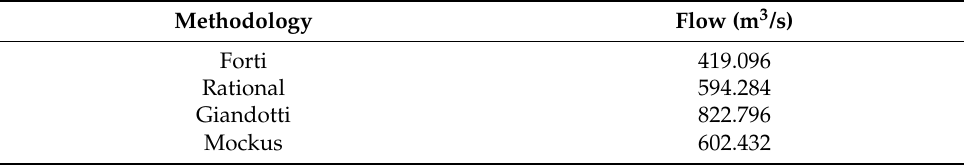
Table 3. Peak flow